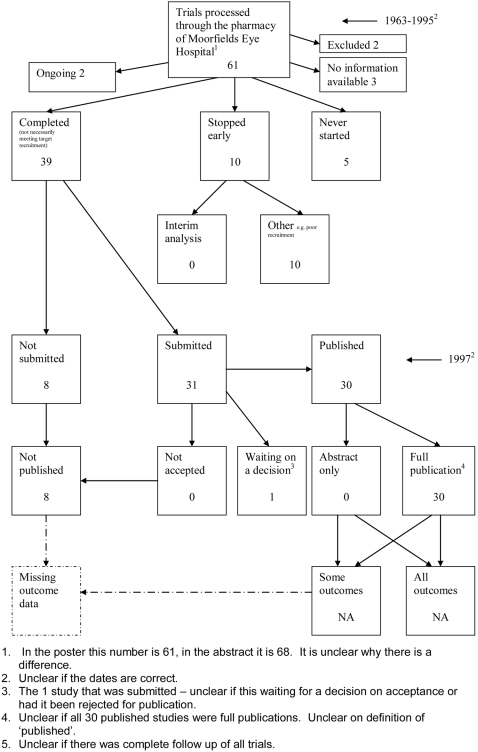
Status of trials for Wormald 1997 study [21].